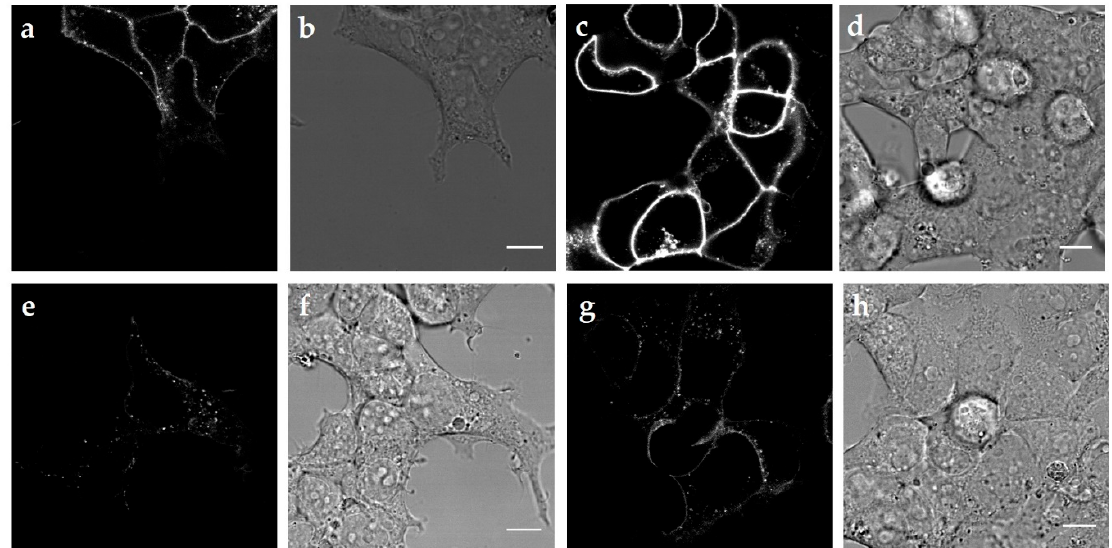
Figure 2. Confocal imaging of MC4R WT and three mutations labeled with TAMRA-NDP- α -MSH. ( a ) Confocal micrograph of cells expressing MC4R WT and ( b ) corresponding di ff erential interference contrast (DIC) image. ( c ) Confocal micrograph of cells expressing MC4R V103I and ( d ) corresponding DIC image. ( e ) Confocal micrograph of cells expressing MC4R S127L and ( f ) corresponding DIC image. ( g ) Confocal micrograph of MC4R H158R and ( h ) corresponding DIC image. Scale bars are 10 µm. Images were acquired 30 min after labeling with 100 nM ligand, and subsequent washout. In panels ( a , c , e,g ) contrast was adjusted to the same overall intensity.